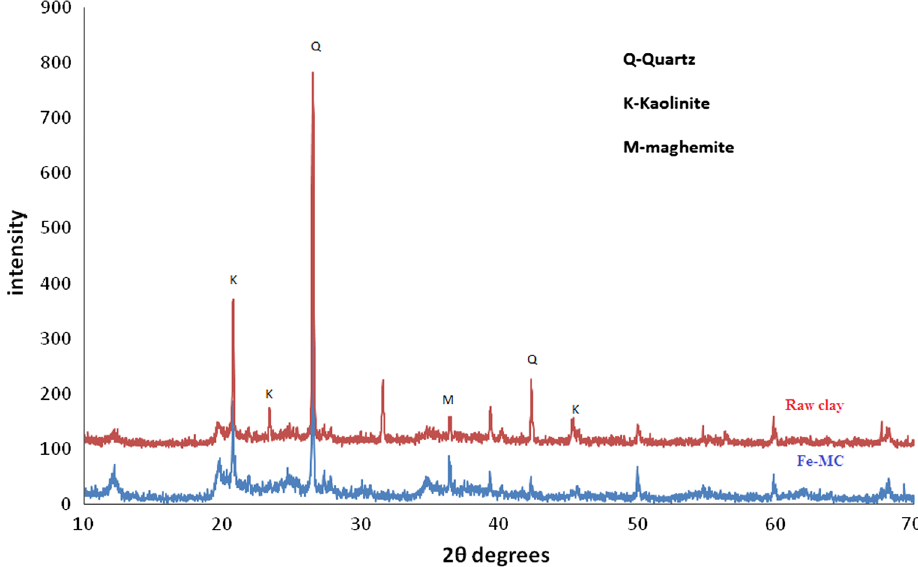
Fig. 2 XRD diffractogram for the raw clay and Fe-MC